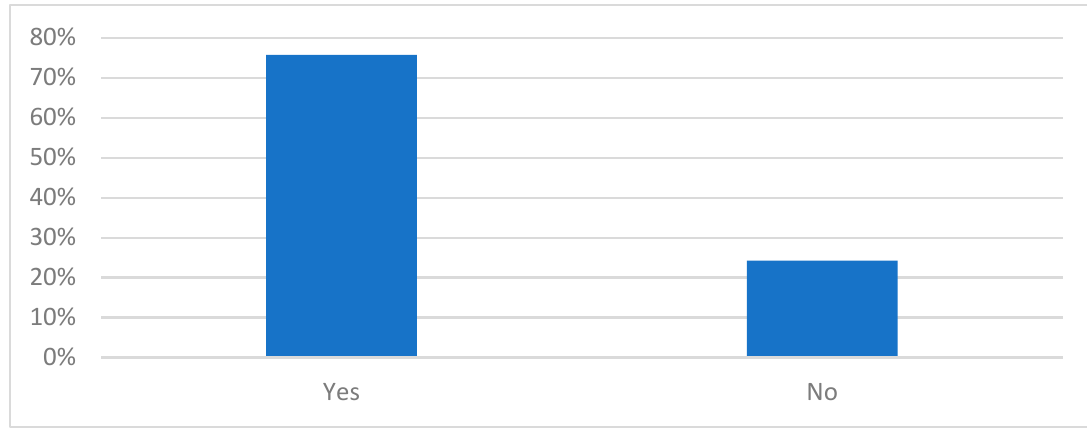
Figure 10. Has the COVID-19 pandemic affected the maritime cyber security landscape? (Asia and Europe).